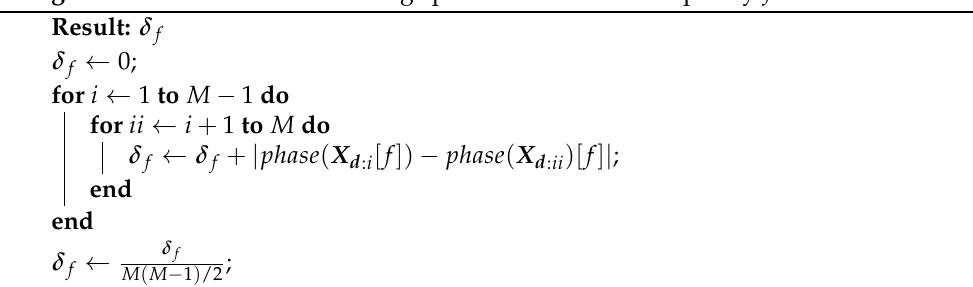
Algorithm 1: Calculated the average phase difference in frequency f